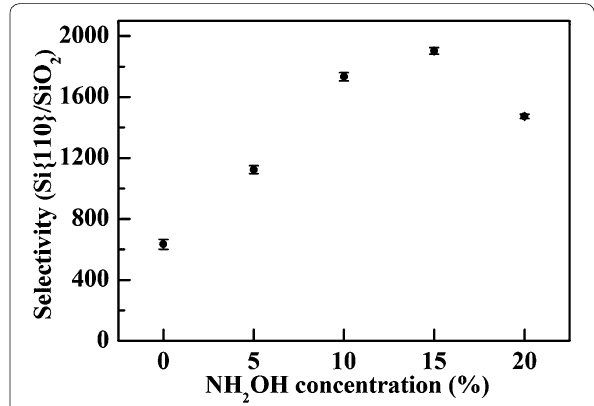
Fig. 3 Etch rate selectivity between Si{110} and silicon dioxide (Si{110}/SiO 2 ) in pure and NH 2 OH-added 20 wt% KOH at 75 °C